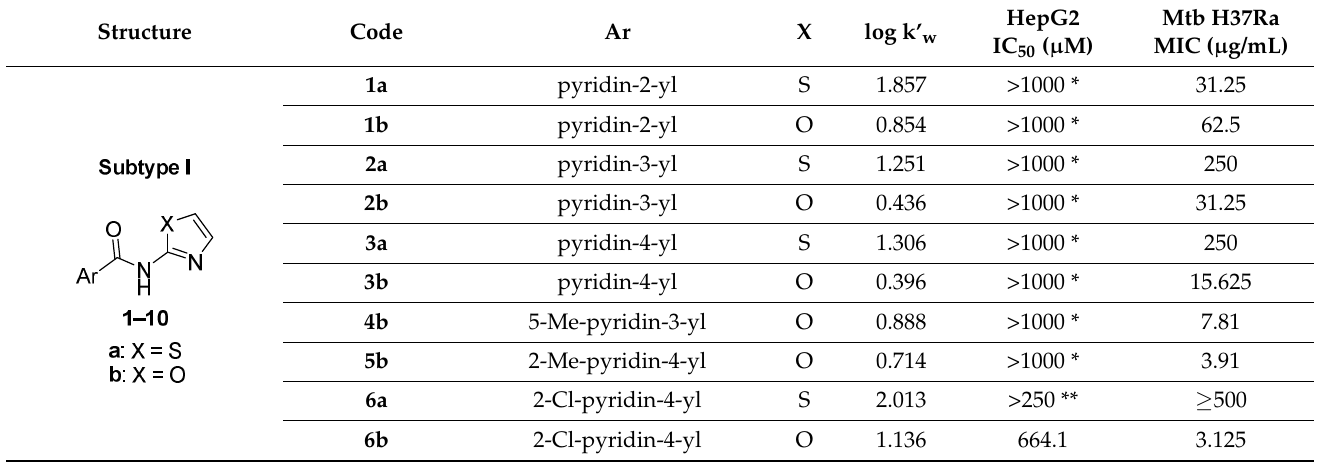
Table 1. Structures, log k’ w , HepG2 cytotoxicity, and MIC against Mtb H37Ra of the title compounds. Structure